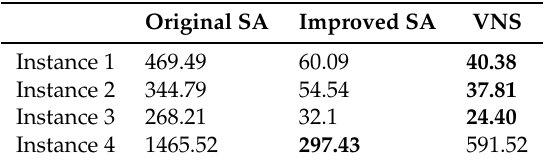
Table 9. Mean accumulated computation times (in